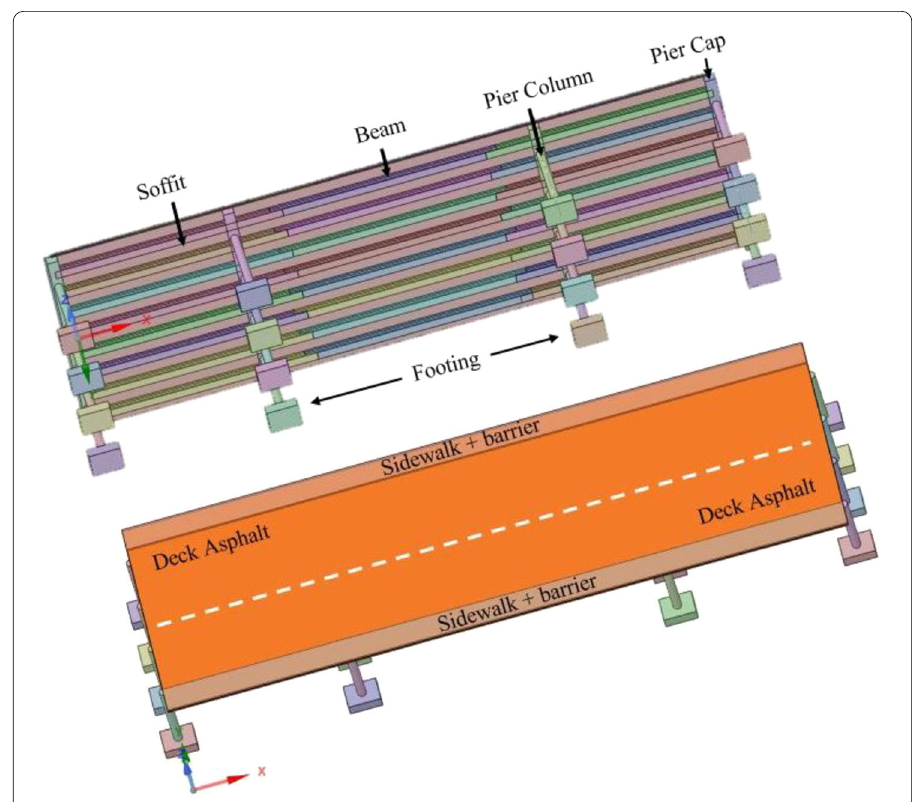
Figure 3 Bridge Parts. Main components of a beam bridge may include a set of steel beams, a floor slab, a two-lane road, two footpaths, pier caps, pier columns, and foundation